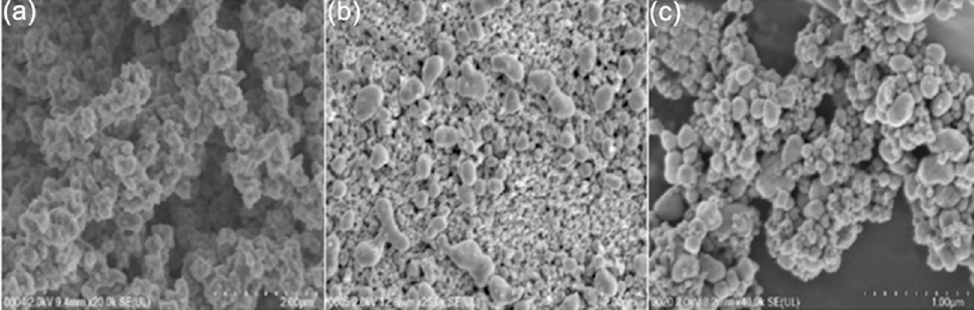
Figure 4. SEM images of ( a ) PANI, ( b ) poly- β -CD, and ( c ) poly- β -CD (f-MWCNTs)/PANI com- posite. Reproduced with permission from [99]. Copyright 2019 Elsevier B.V. permission from [99]. Copyright 2019 Elsevier